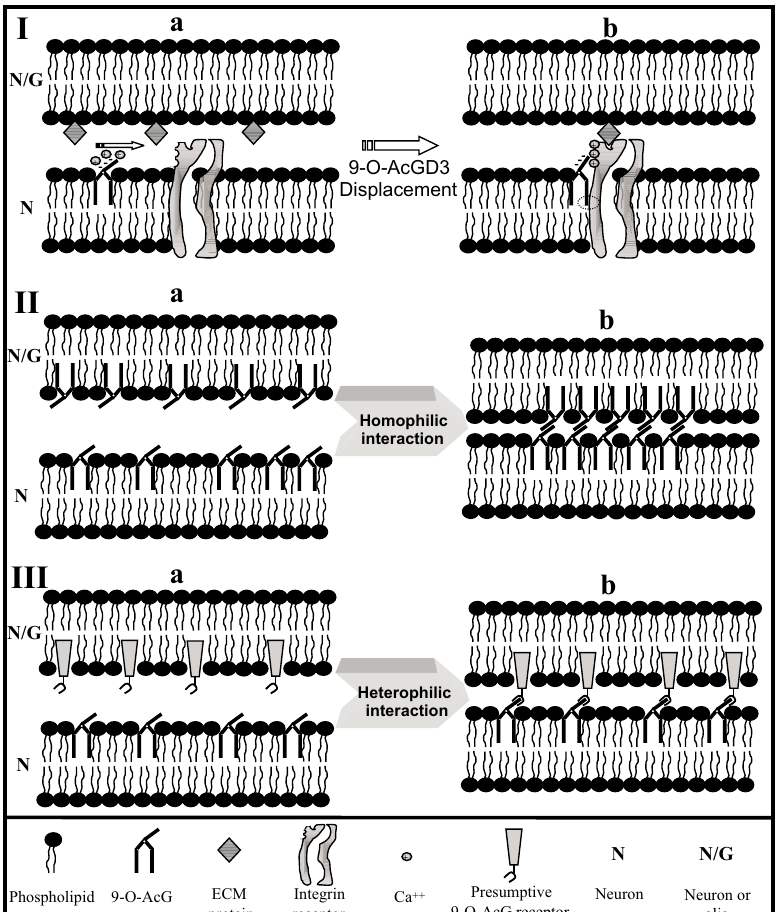
Fig. 1 – Schematic diagrams suggesting three possible mechanisms for 9-O-acetyl GD3 (9-O-AcG) action in gliophilic or neuronophilic neuronal migration. I: The ganglioside 9-O-AcG modulates the integrin receptor through a Ca ++ dependent mechanism and/or by a direct interaction between the cerebroside moiety of the ganglioside and the integrin transmembrane helix (TMH). In a first stage (a) , the integrin receptor is inactive and there is no recognition of extracellular matrix (ECM) proteins. Later on (b) , the gangliosides in the adjacent membrane become laterally packed around the integrin receptor (represented on the scheme by only one ganglioside), providing an optimal Ca ++ microenvironment for the activation and recognition of ECM proteins by this receptor. In addition, the gangliosides can interact directly with the integrin receptor through a conserved lysine located inside a 23 amino acids sequence at the carboxy-terminal of the TMH (outline). II: Homophilic interaction between gangliosides located at different cell membranes. In (a) , two cells containing 9-O-AcG randomly spread over the membranes. In (b) , the cells are interacting in a homophilic manner through a carbohydrate-carbohydrate interaction of the gangliosides. III: Heterophilic interaction between the gangliosides and a potential specific receptor. In (a) , a cell containing the ganglioside 9-O-AcG in the membrane and another cell expressing a presumptive receptor. In (b) , the cells are interacting by the way of a specific recognition between the ganglioside 9-O-AcG and its particular receptor. This interaction could trigger a specific cascade of reactions in both cells (not illustrated in the